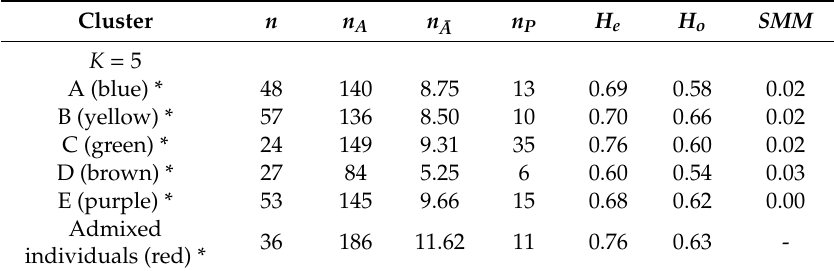
Table 1. Genetic diversity indices and BOTTLENECK analysis of STRUCTURE clusters of Emys trinacris . Colours refer to clusters (see Figure 1). The category admixed individuals comprises turtles with admixed genotypes irrespective of their collection sites.